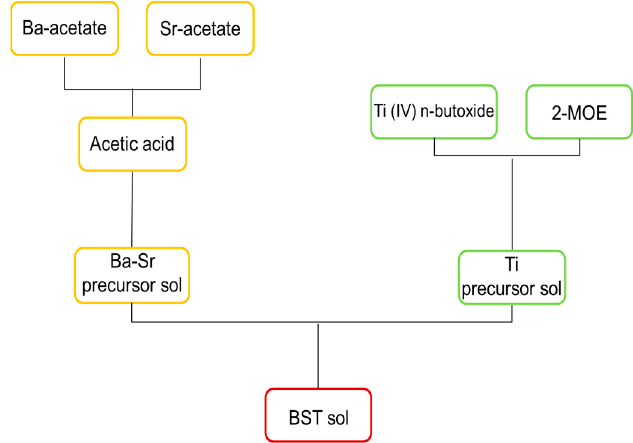
Figure 1. Synthesis of Ba x Sr (1 − x) TiO 3 [3].